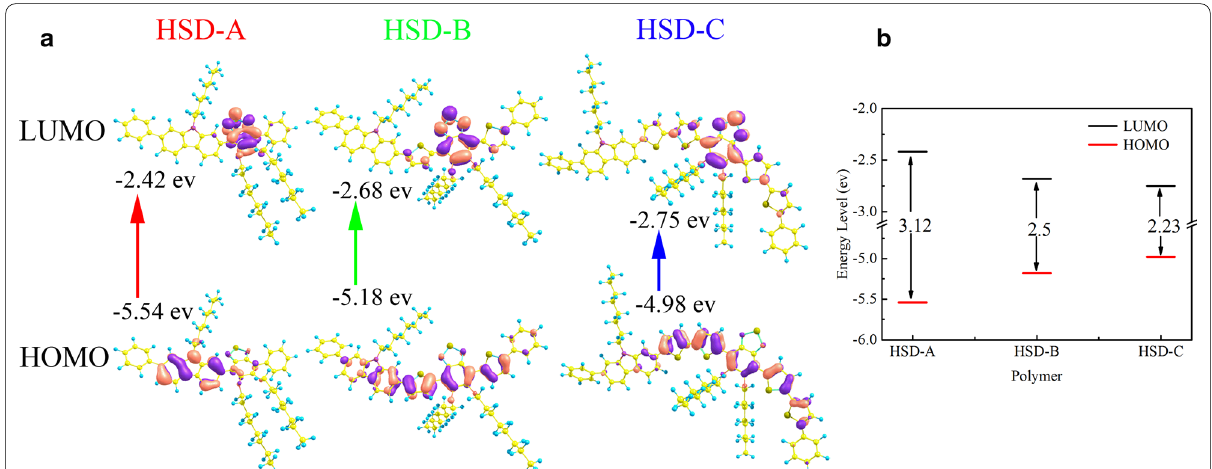
Fig. 2 Frontier molecular orbitals of HSD copolymers ( a ) calculated using the B3LYP-D3 functional with6-311G** basis set and the HOMO and LUMO energy levels ( b